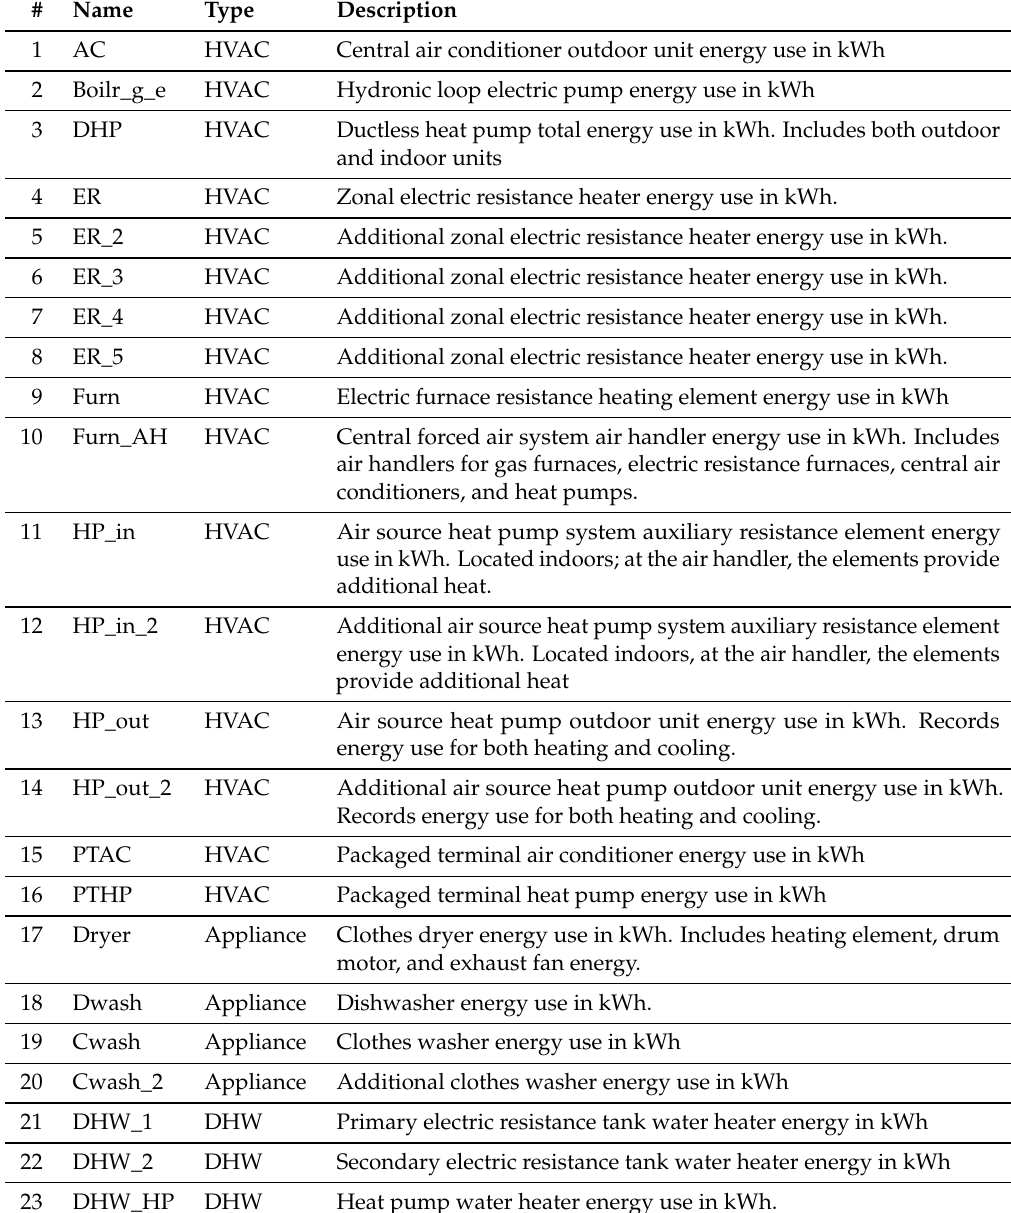
Table 1. Description of residential loads identified as